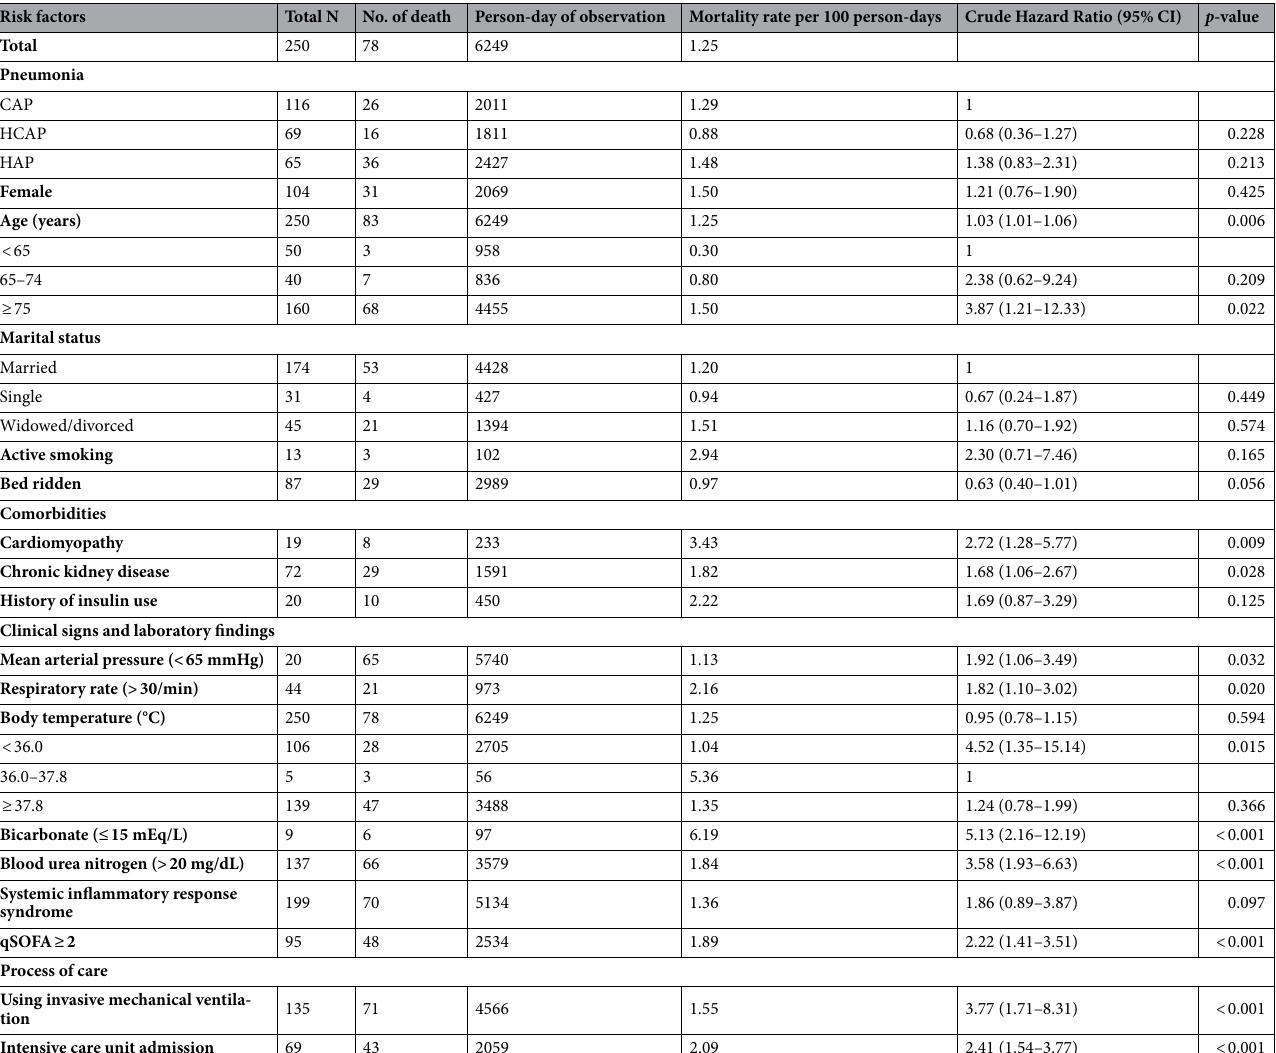
Table 3. Univariable cox regression analysis for risk factors of inhospital mortality. CAP; community-acquired pneumonia, HCAP; healthcare-associated pneumonia, HAP; hospital-acquired pneumonia, qSOFA; quick sequential organ failure